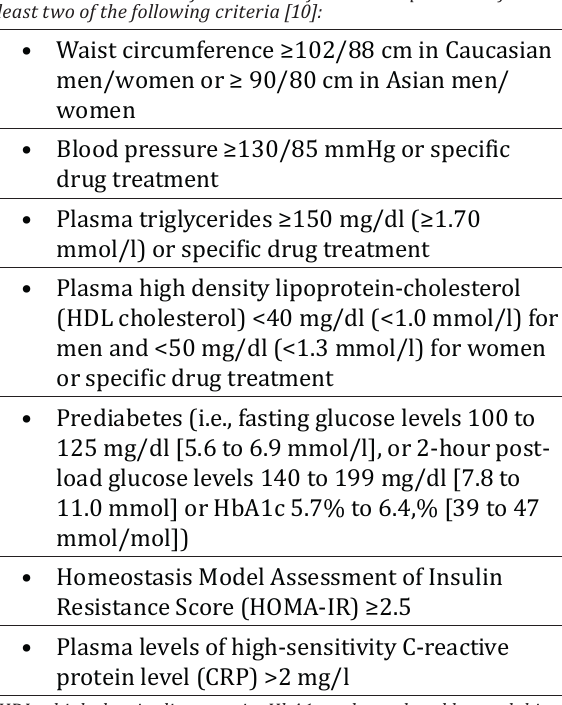
Table 2. Metabolic risk factors are defined as the presence of at least two of the following criteria [10]: